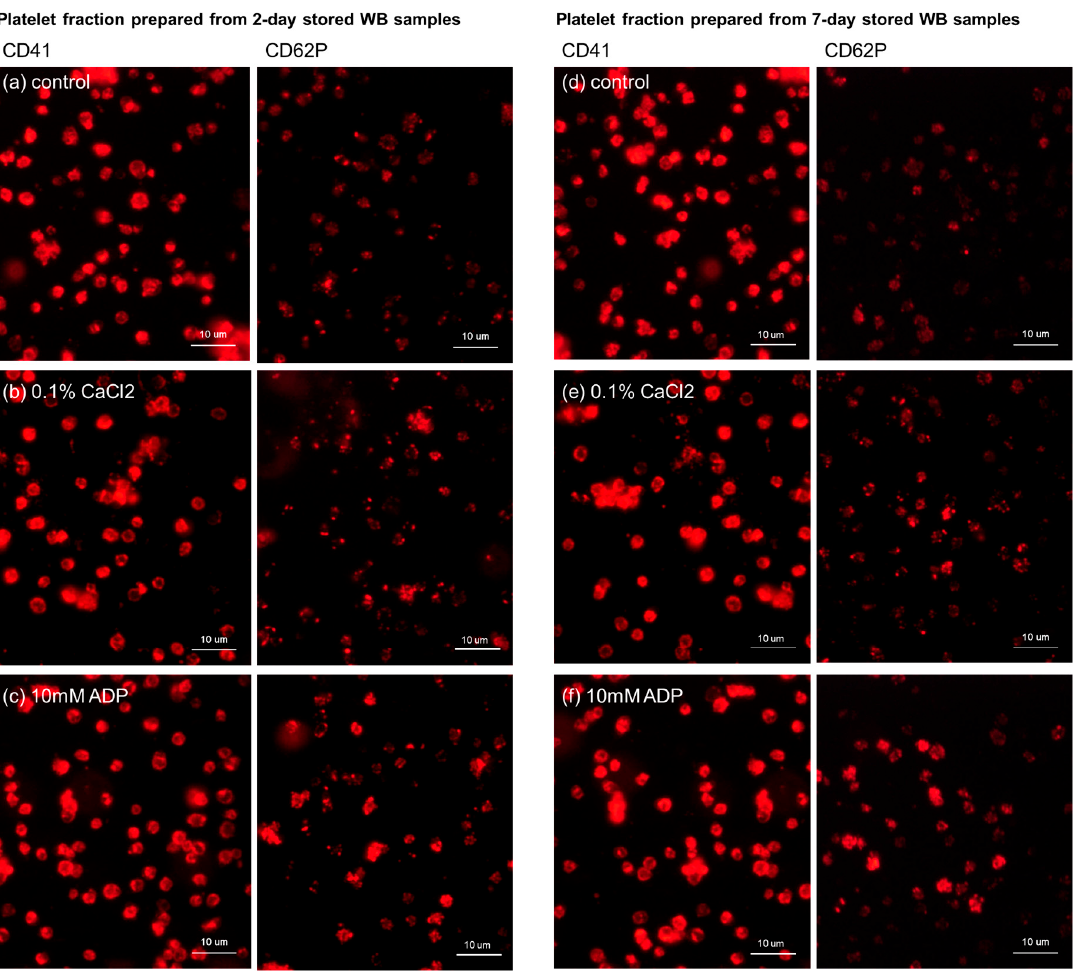
Figure 2. Immunofluorescent staining of CD41 and CD62P expressed in platelets isolated from 2-day- or 7-day-stored WB samples. ( a , d ) Control resting platelets; ( b , e ) platelets stimulated by 0.1% CaCl 2 for 15 min; and ( c , f ) platelets stimulated by 10 mM ADP for 15 min. The platelets were derived from the same donor and were distributed with almost the same density in all the dishes (views).